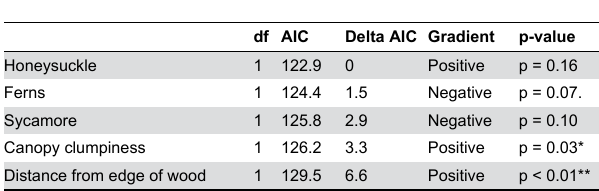
Table 3. Variables found to be important for dormouse nestbox selection, as determined by a binary stepwise logistic